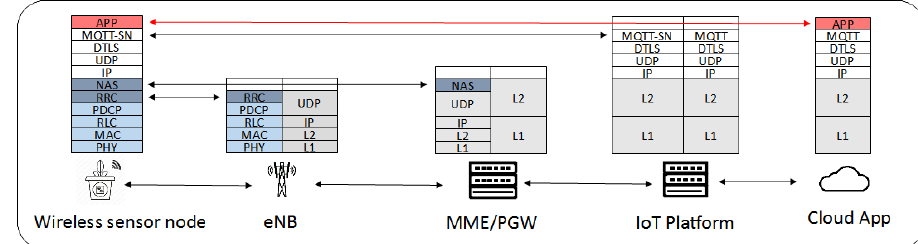
Figure 1. NB-IoT system overview with an exemplary protocol